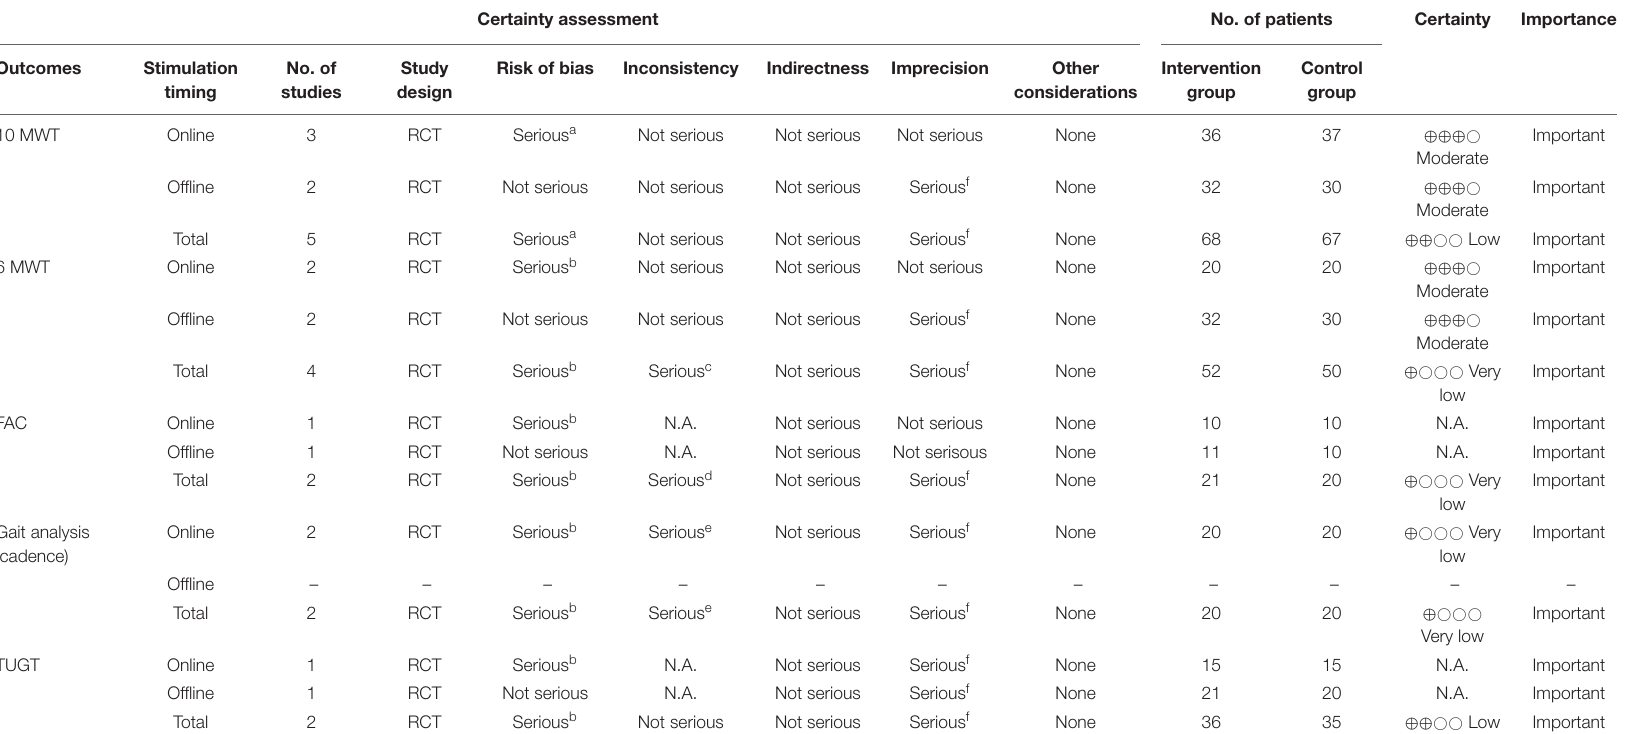
TABLE 3 | Summary of GRADE